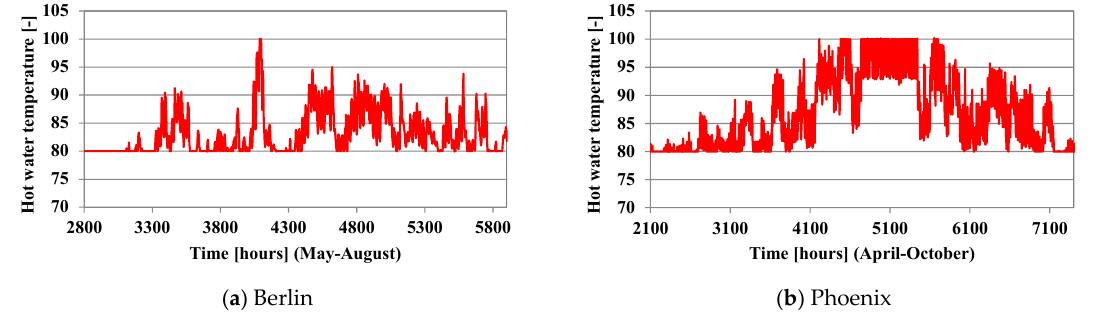
Figure 15. The variation of the required solar hot water temperature for two locations.